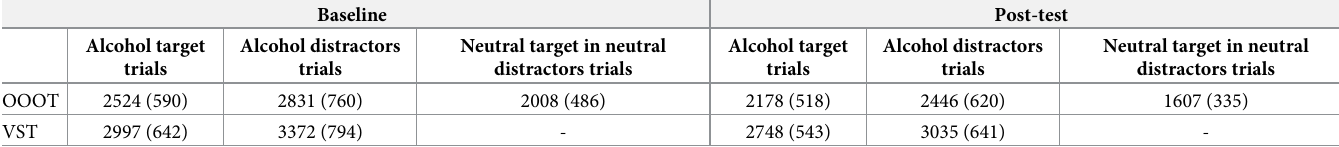
Table 2. Alcohol target trials, alcohol distractors trials and neutral target in neutral distractors trials as measured with the Odd-One-Out Task and the Visual Search Task at baseline and post-test.